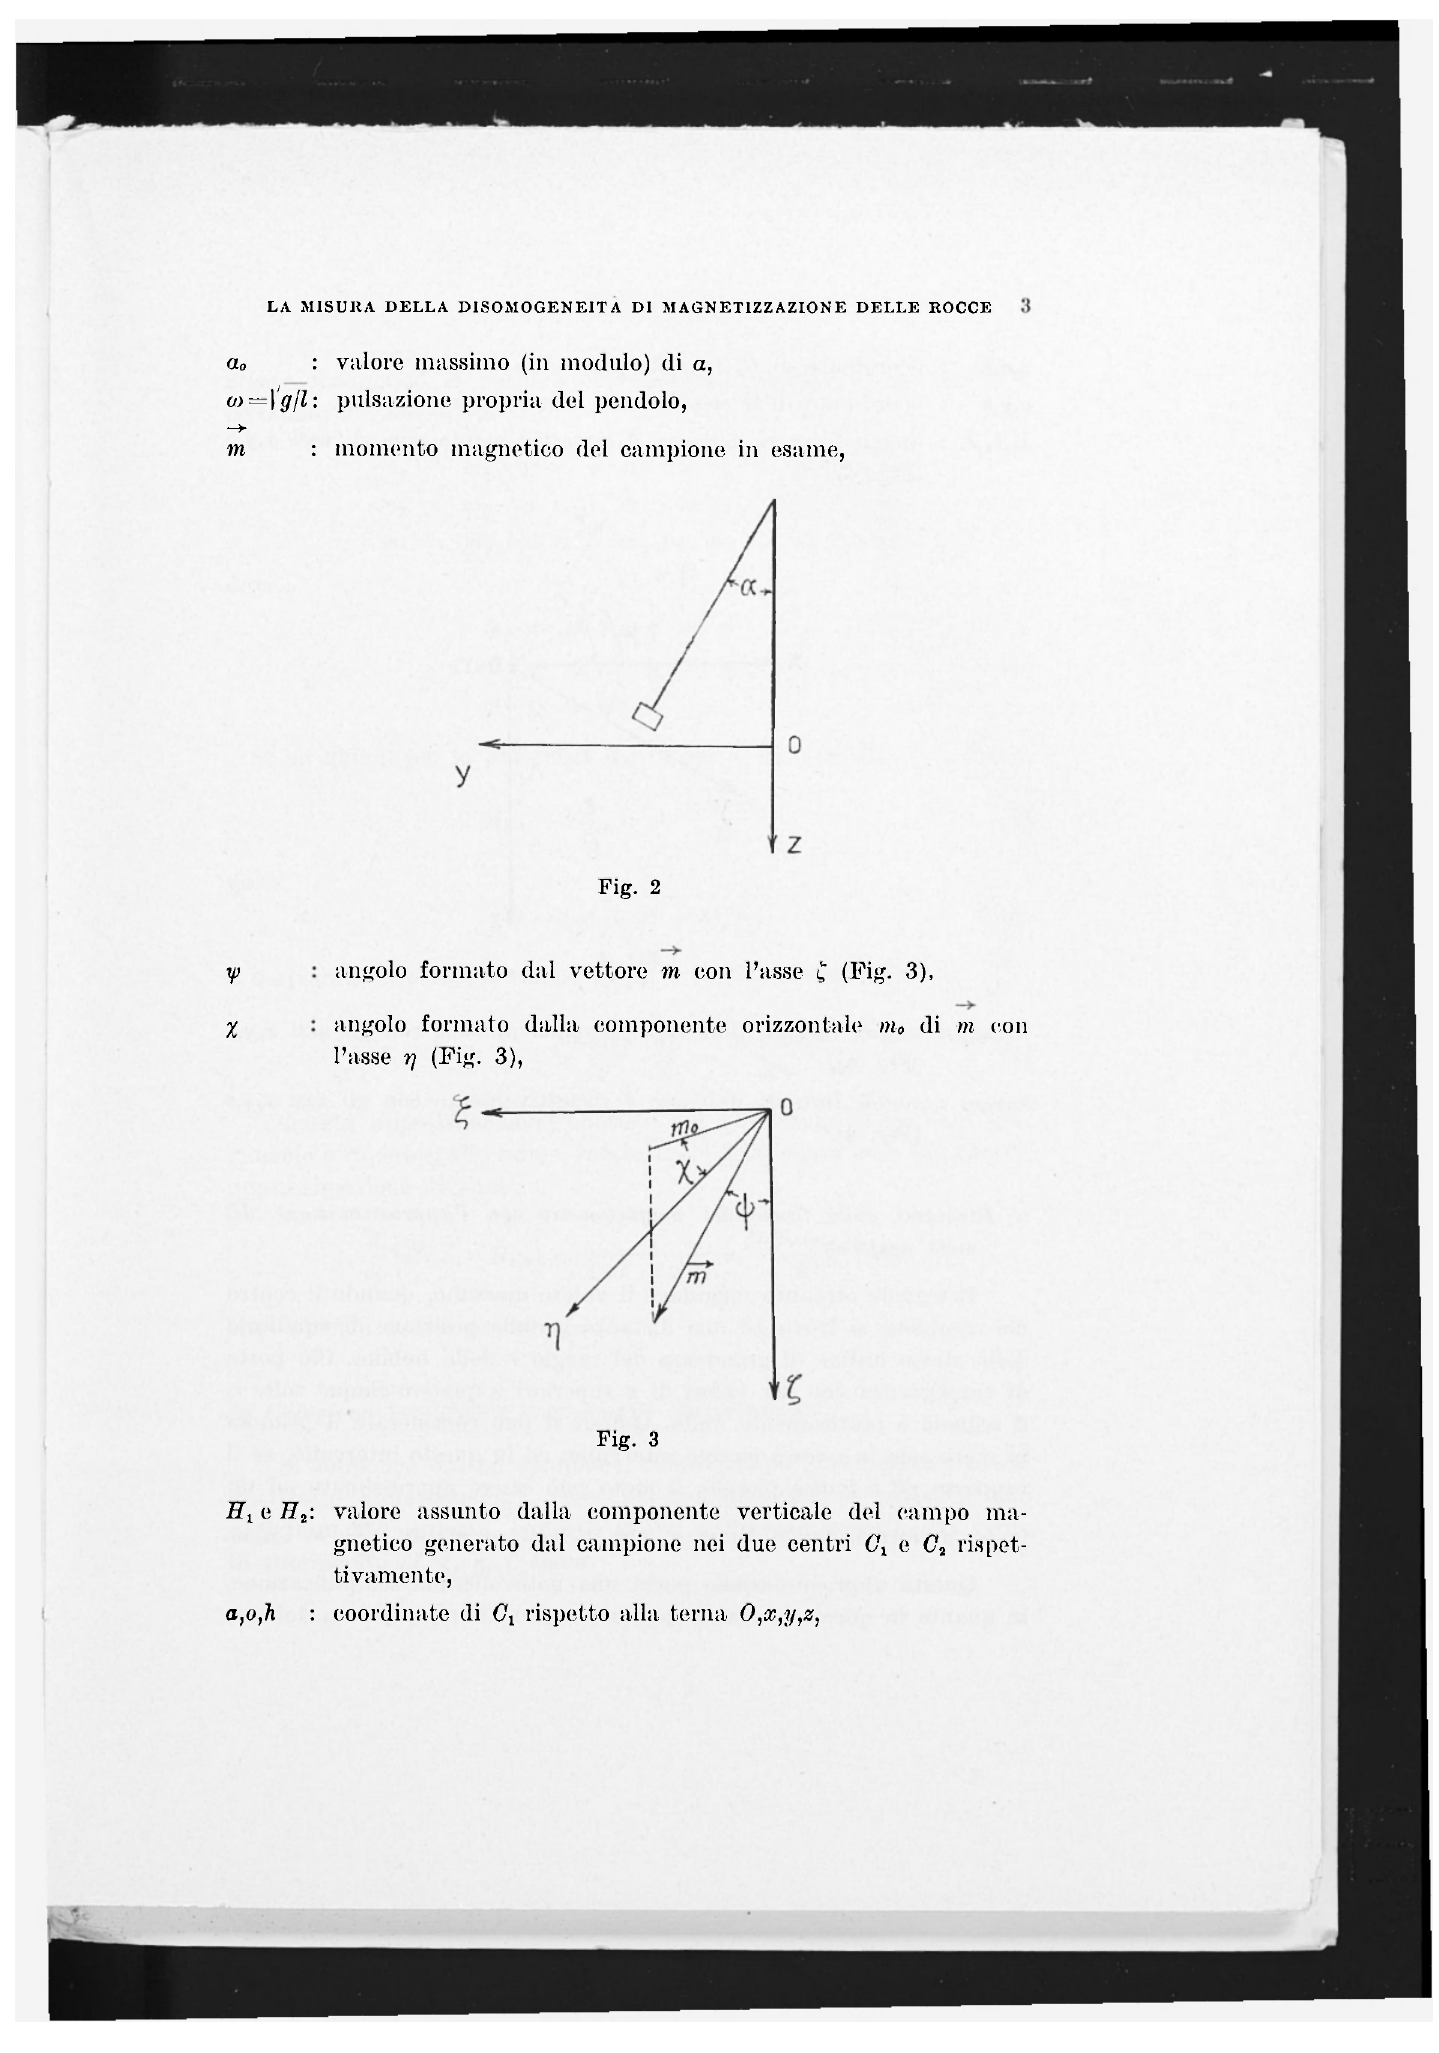
Hi e H 2 : valore assunto dalla componente verticale del campo ma- gnetico generato dal campione nei due centri O, e C 2 rispet-